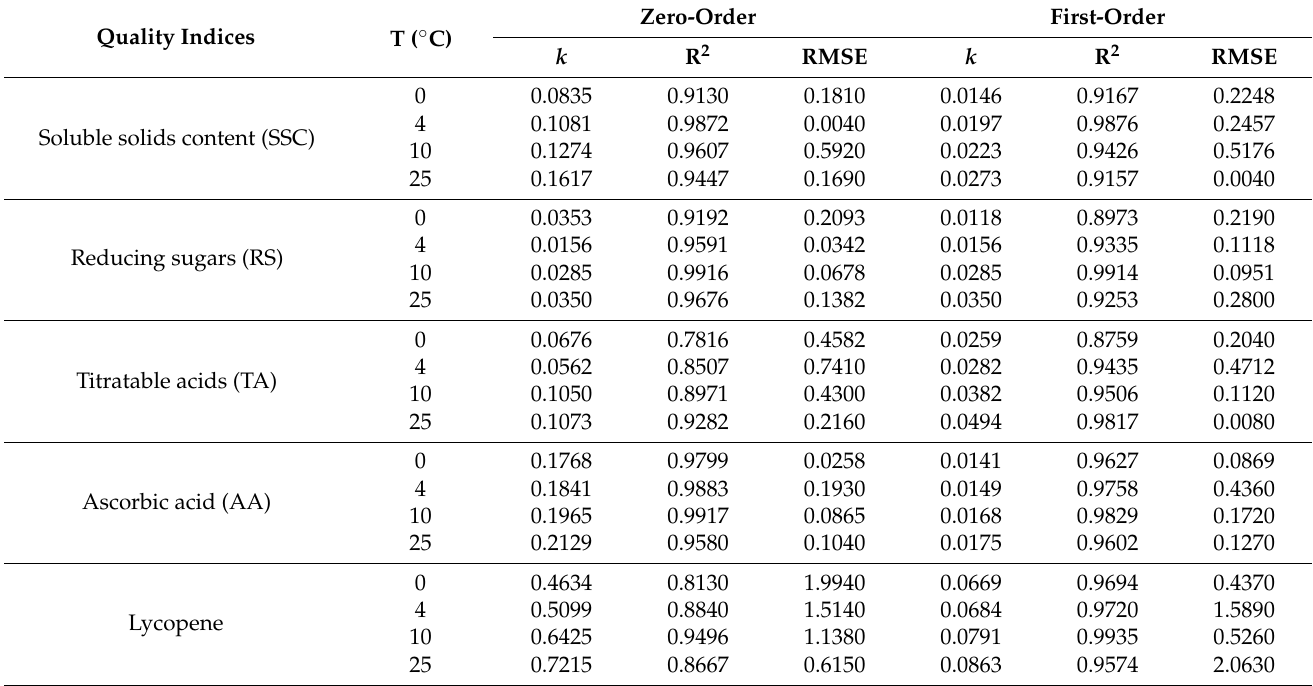
Table 1. Rate constants ( k ), coefficients of determination (R 2 ) and root mean square error (RMSE) of the zero-order and first-order kinetic regressions for nutritional quality changes in cherry tomatoes at different storage